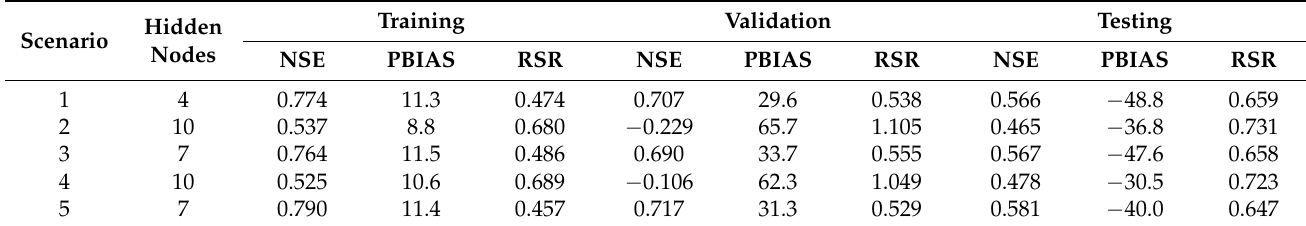
Table 4. BlockedCV selected models with the optimum number of hidden nodes, HSARB.